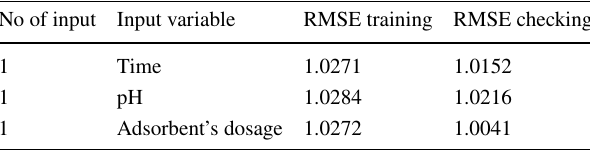
Table 5 One-input variable ANFIS (exhaustive search) for vanadium